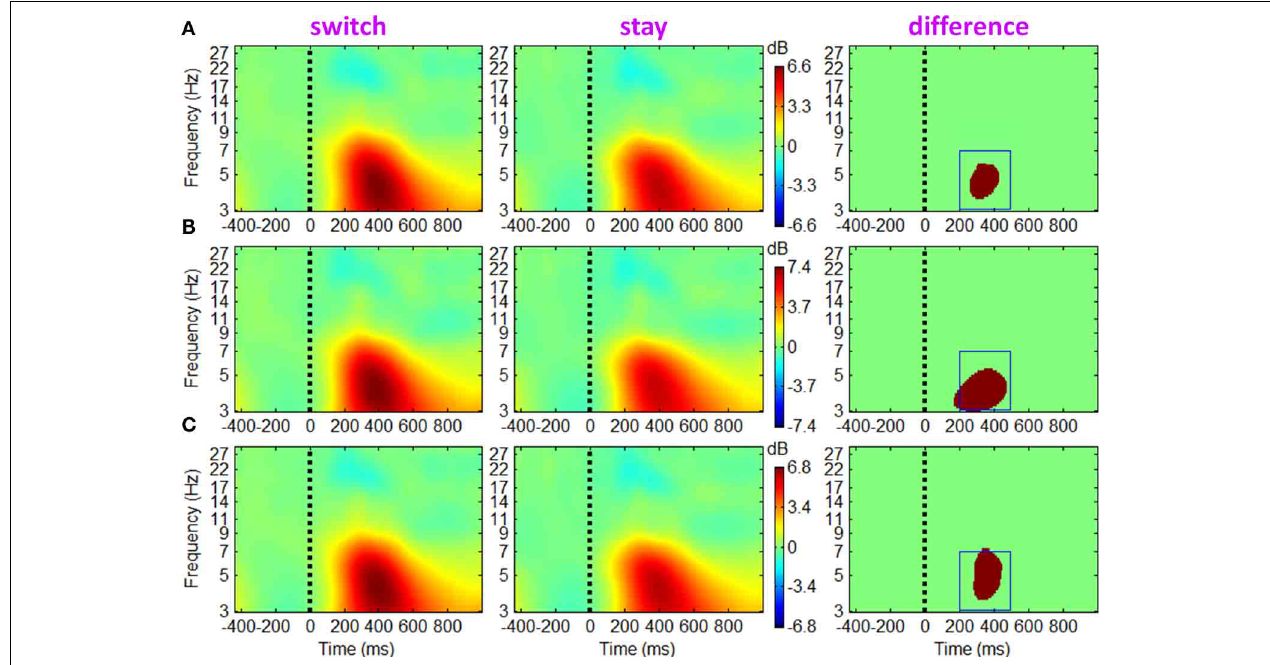
FIGURE 4 | Grand-mean ERSPs of the main effect of subsequent strategy based on channel EEG data. Results obtained from sites Fz, Cz and Pz are shown in (A–C) . Colored ERSP images of switch and stay trials (the subplots in the first two columns) were produced using permutation statistics, with the red and blue indicating power increase or decrease; green areas indicate